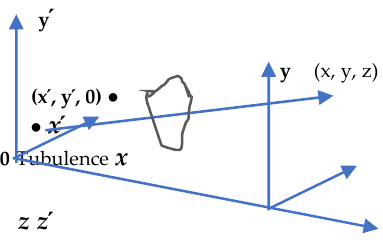
Figure 1. The schematic diagram of a signal transmission from the light source plane ( x ’, y ’, z ’) to the receiving plane ( x , y , z ).